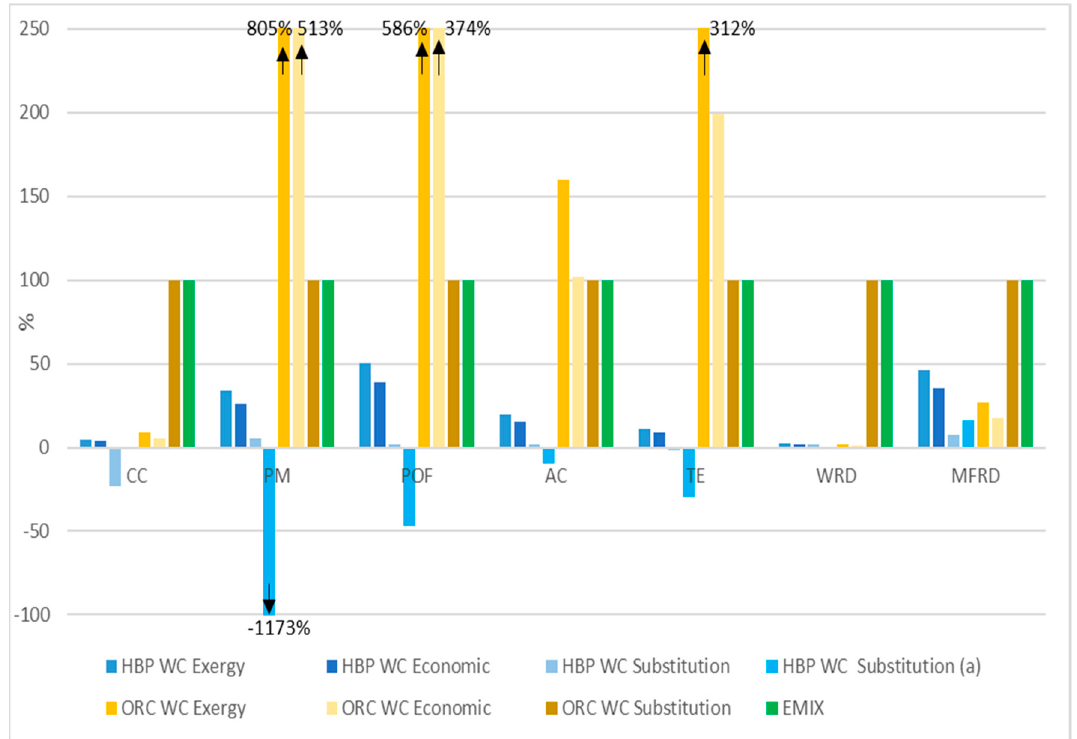
Figure 10. Sensitivity on allocation method for the generation of 1 kWh with HBP technology and competing technologies (1 kWh electricity). Electricity mix taken as 100%. ORC = Organic Rankine Cycle, EMIX = Electricity mix, (a) = substitution of heat from a biomass boiler.